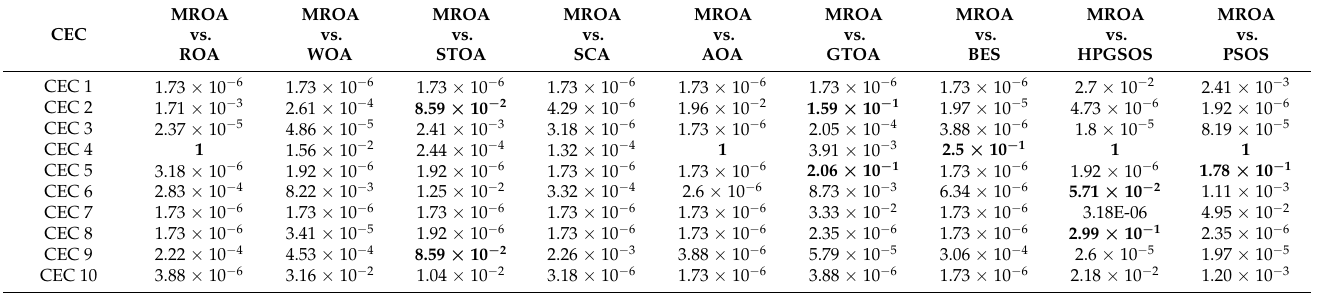
Table 9. Results of the Wilcoxon signed-rank test between MROA and other metaheuristic algorithms (CEC 1–CEC 10) with dim = 10 (run 30 times). (Bold makes the Wilcoxon rank-sum test more effective). MROA vs.